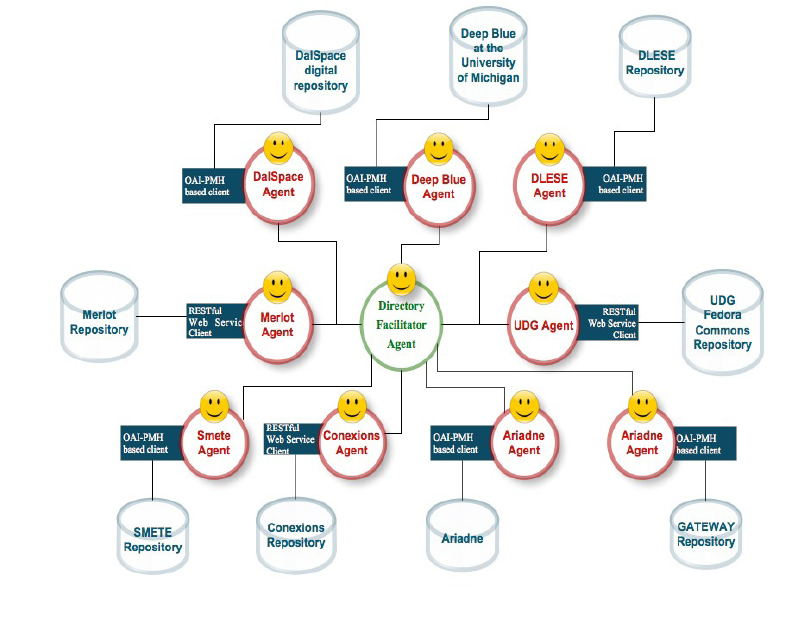
Figure 1 . LORSE Multiagent